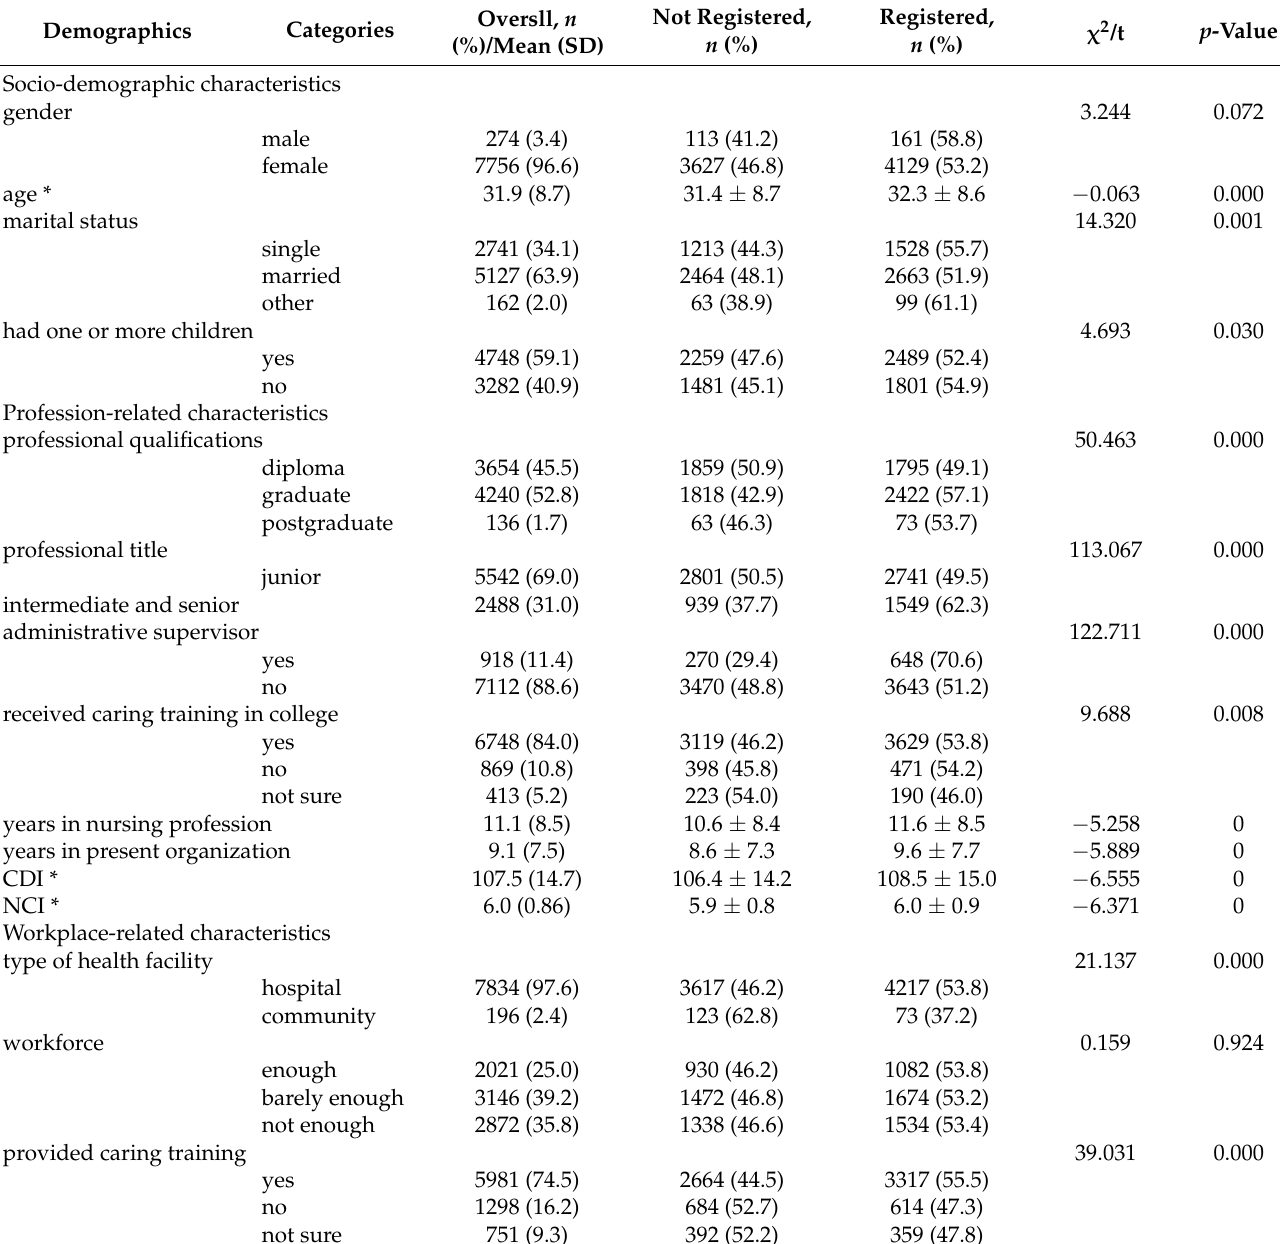
Table 1. Characteristics of participants and their willingness to participate in the fight against COVID-19 ( n =